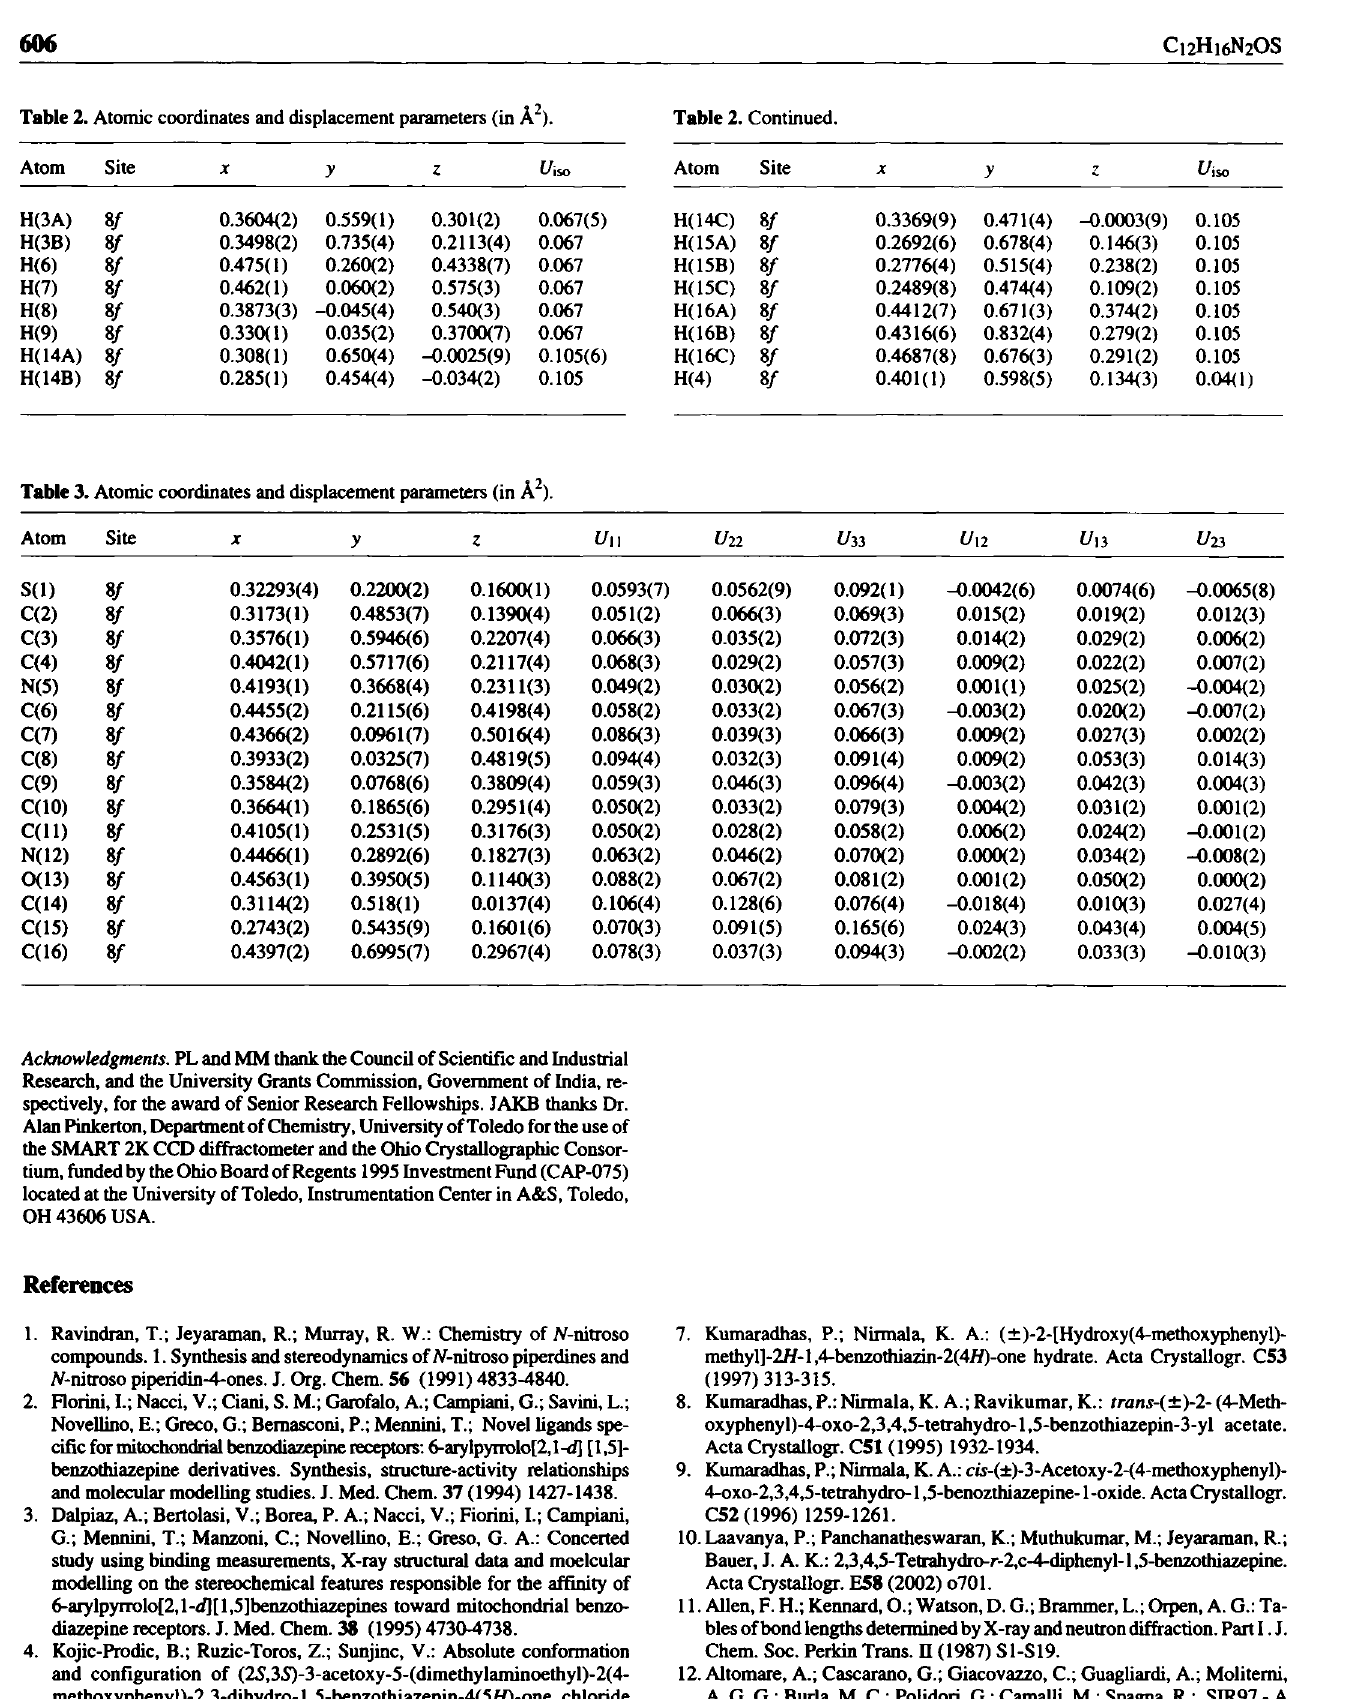
Table 2. Atomic coordinates and displacement parameters (in Â 2 ). Table 2. Continued.